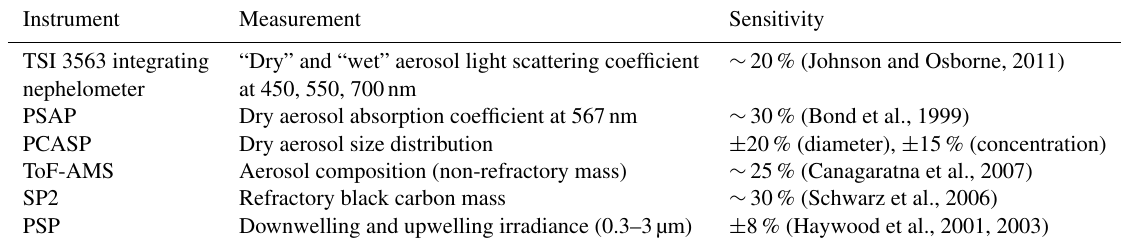
Table 2. Summary of the aerosol and radiation sampling instrumentation aboard the FAAM BAe-146 during the EUCAARI-LONGREX